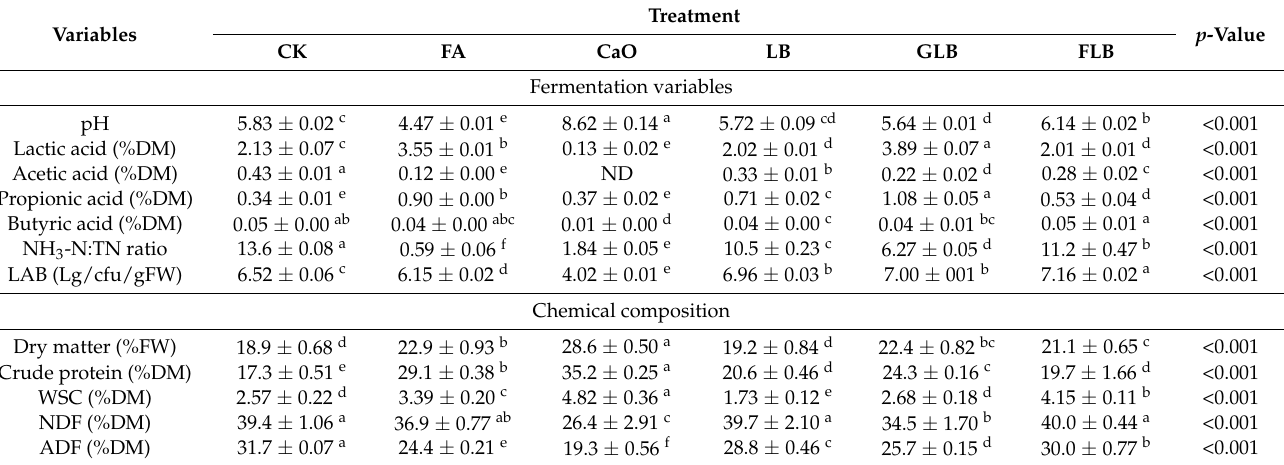
Table 2. Fermentation variables and nutrient contents of alfalfa silages after 60